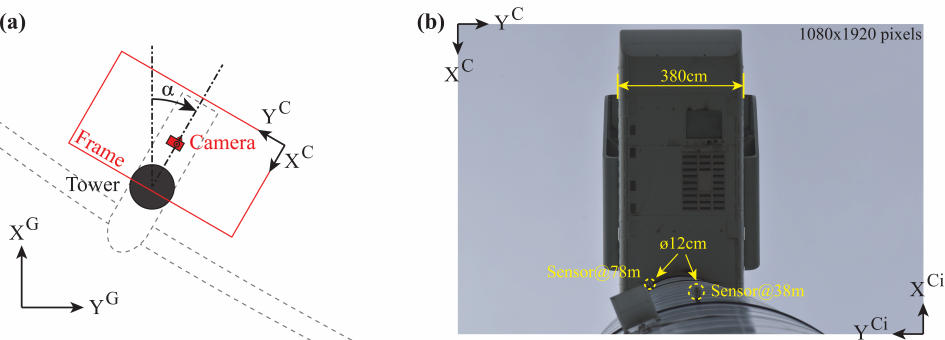
Figure 6. Example of ( a ) the camera setup with the respective coordinate systems and ( b ) a sample frame with annotations, where the two sensors firmly mounted on the tower are outlined with